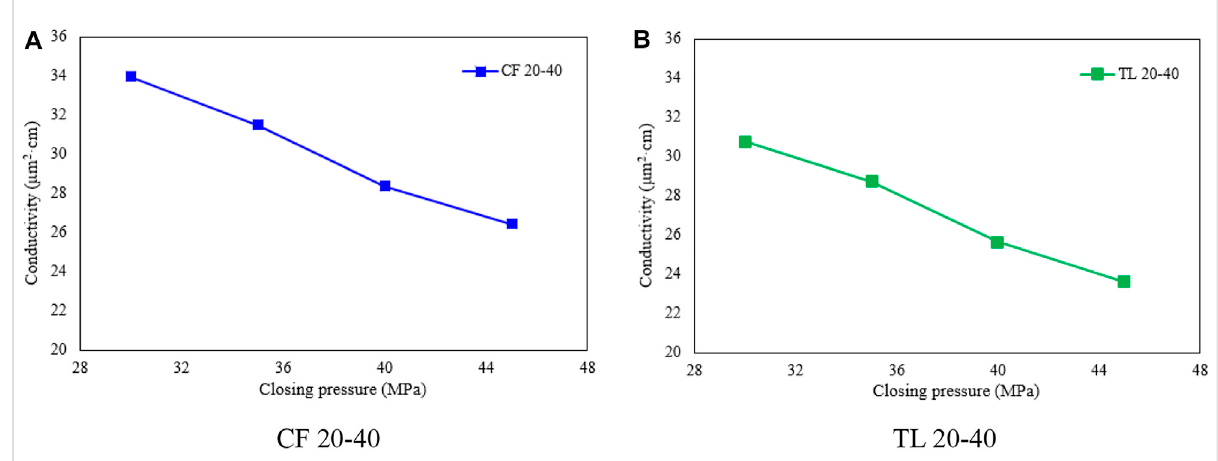
FIGURE 6 The conductivity of 20 – 40 mesh proppant varies with the closing pressure.